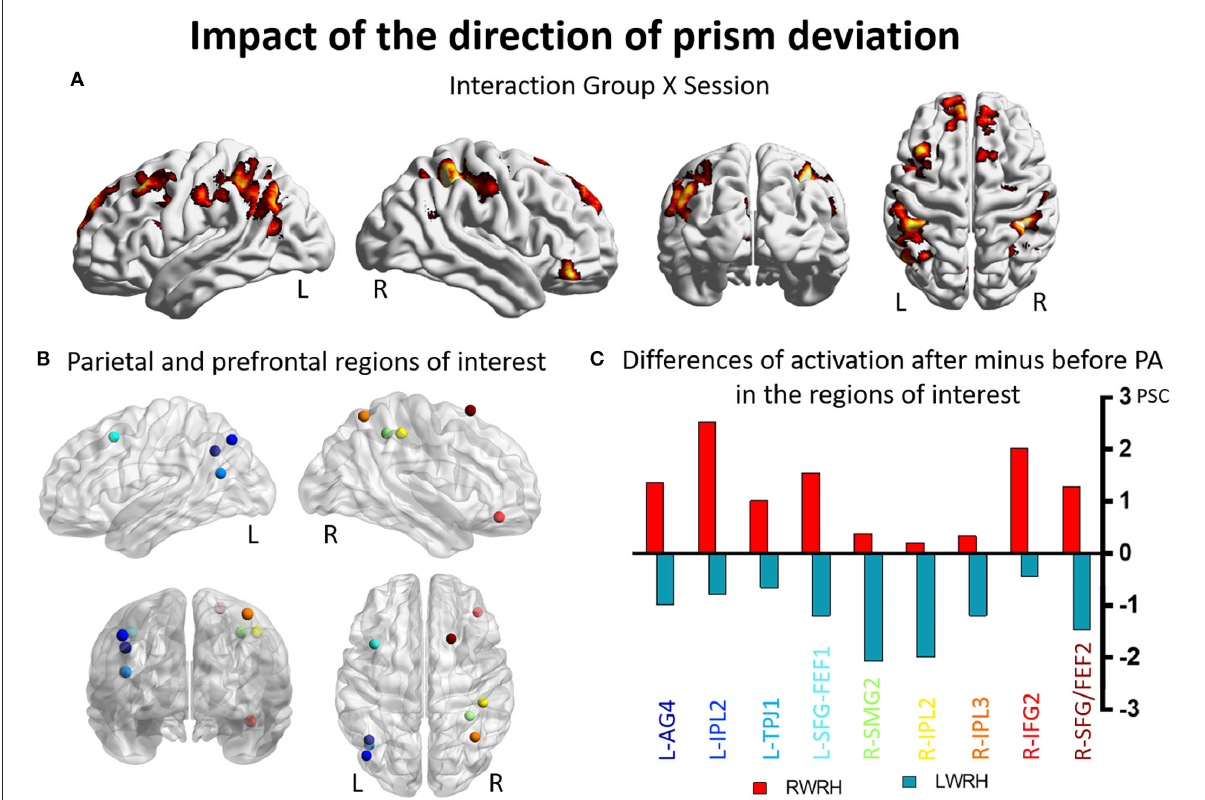
FIGURE3 Impact of the direction of the prism deviation on the reshaping of visuo-spatial representations. Modulation of brain activation as revealed by the ANOVA including the groups RWRH and LWRH. (A) Surface renderings of significant brain activation in the interaction between the factors Group (RWRH, LWRH) x Session (pre, post), from left to right: lateral views of the left and right hemisphere, view from the back and the top. All maps are thresholded at p < 0.05, cluster extent k > 82. (B) Spheres located on the peaks of activation clusters in the parietal and prefrontal regions. Lateral views of the left and right hemispheres, above the back and top views. Color code denotes names of the regions, as indicated on the x -axis in C. (C) Differences of activation in percent signal change, after minus before PA, for the group RWRH (in red) and LWRH (in green). AG, angular gyrus; FEF, frontal eye field; IFG, inferior frontal gyrus; IPL, inferior parietal gyrus; L, left; PSC, percent signal change; R, right hemisphere; SFG, superior frontal gyrus; SMG, supramarginal gyrus; TPJ, temporo-parietal